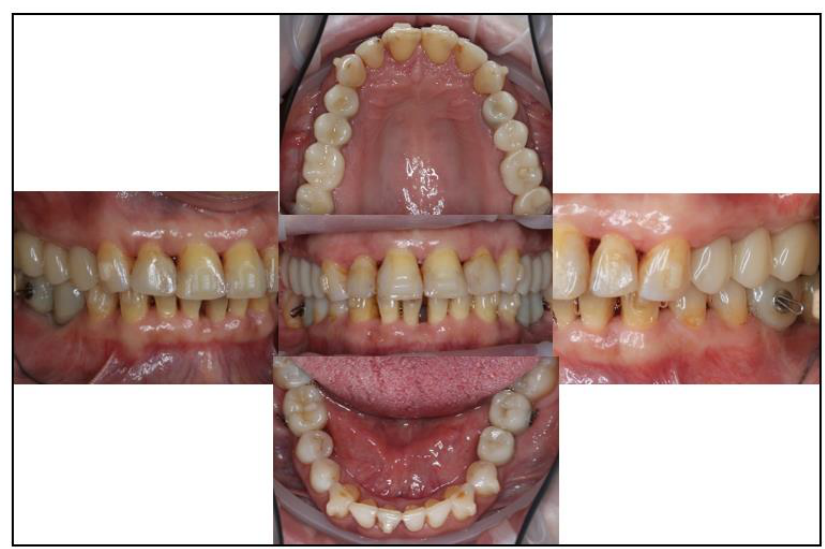
Figure 18. Intraoral pictures after the first set of aligners .